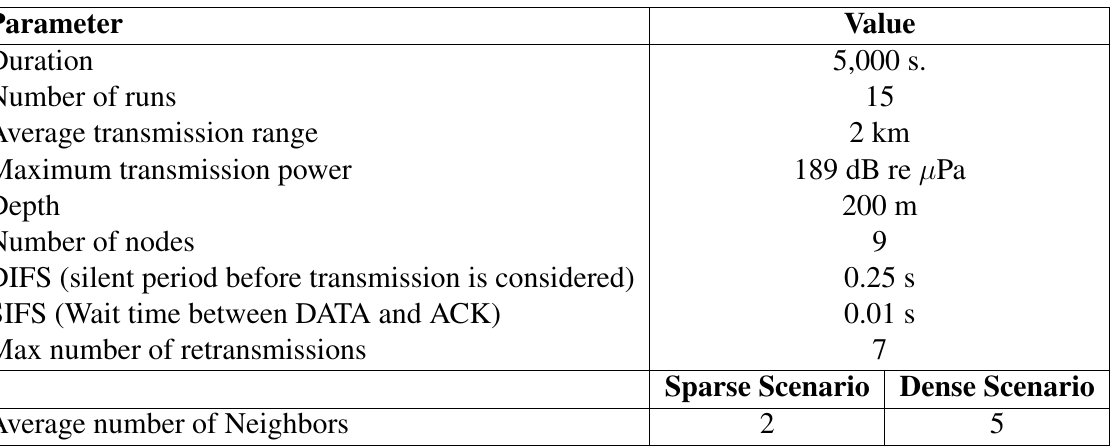
Table 2. Simulation